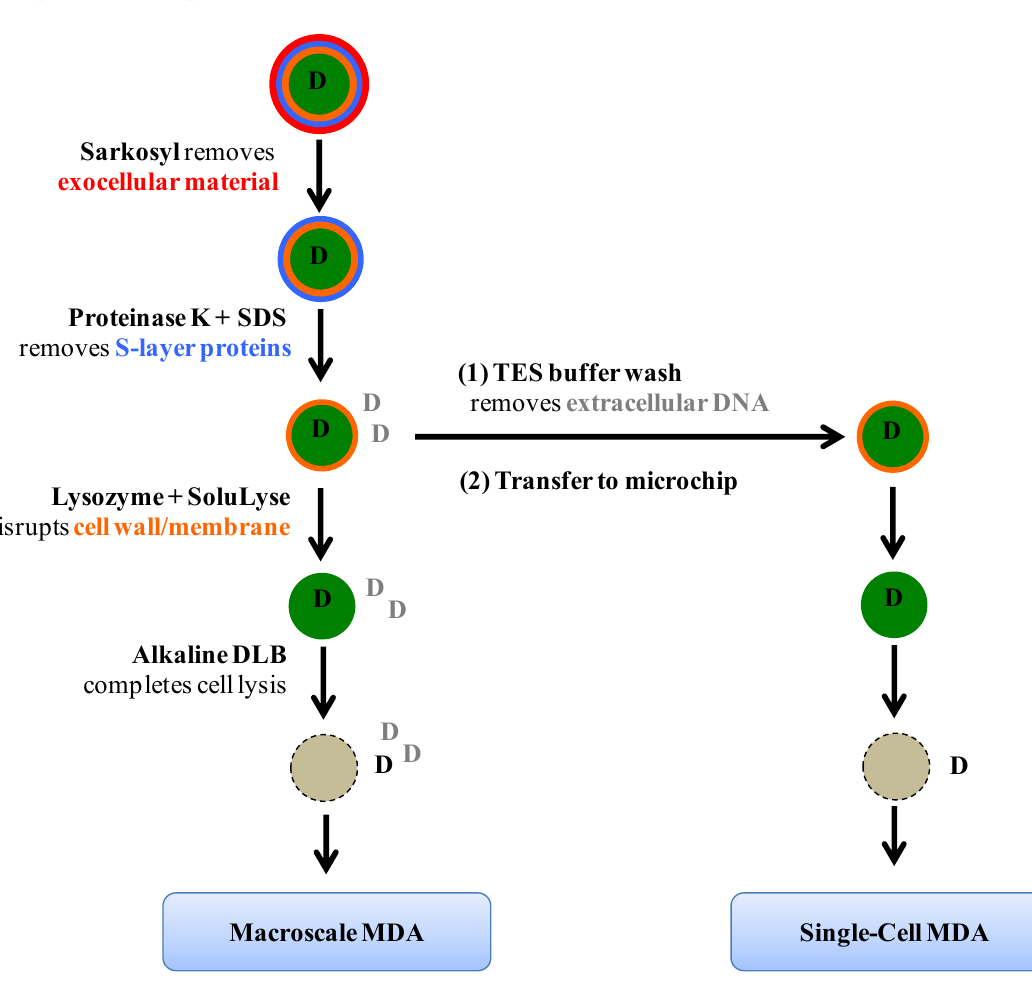
Figure 1. Schematic of the lysis protocol. Cellular layers and chemical reagents used to remove them are shown. The letter D stands for DNA molecules; D in black represents genomic materials originated from captured single cyanobacteria cells whereas D in grey indicates DNA from other cells, either cyanobacteria of interest or different species; this type of DNA is termed “contaminant DNA” in the text for describing single-cell genome amplification